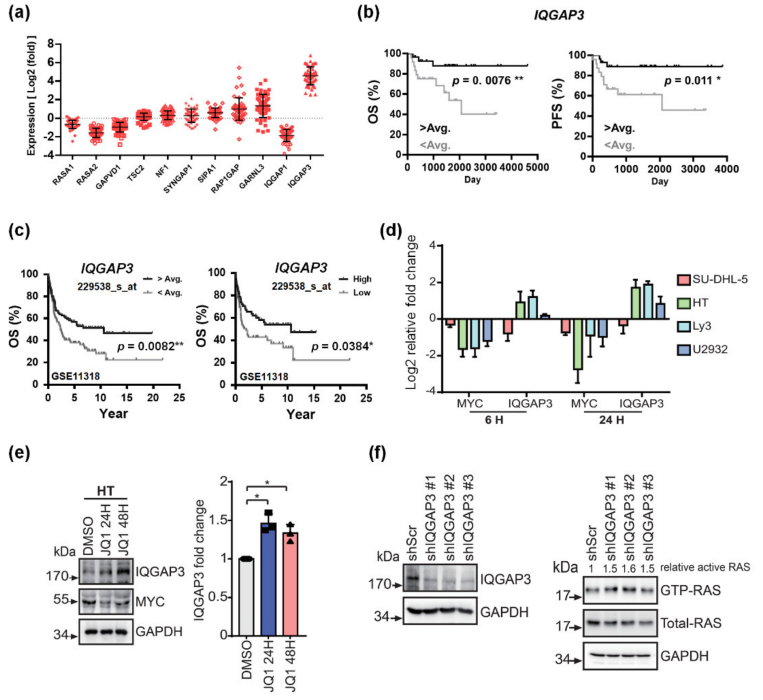
Figure 4. IQGAP3 mediates JQ1-induced RAS inactivation and portends a better survival in DLBCL patients. ( a ) Expression levels of several RASGAP genes in DLBCL samples. Folds of expression